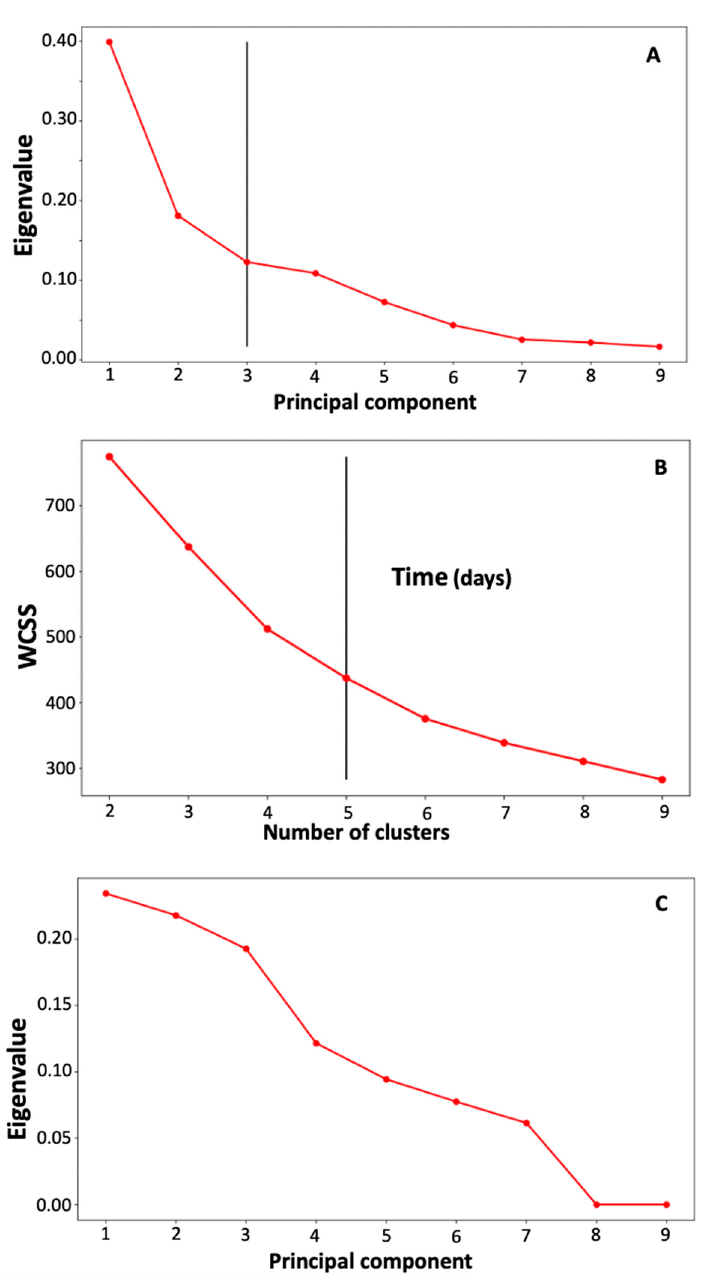
Figure A1. Scree (elbow) plots to determine the number of principal components or clusters in principal component analysis ( A ), k-means clustering ( B ), and factor analysis of mixed data ( C ). The x-axis refers to the number of principal components or clusters, while the y-axis corresponds to eigenvalues (for A and C ) and the Within-Cluster Sum of Square (WCSS) (for plot B ).